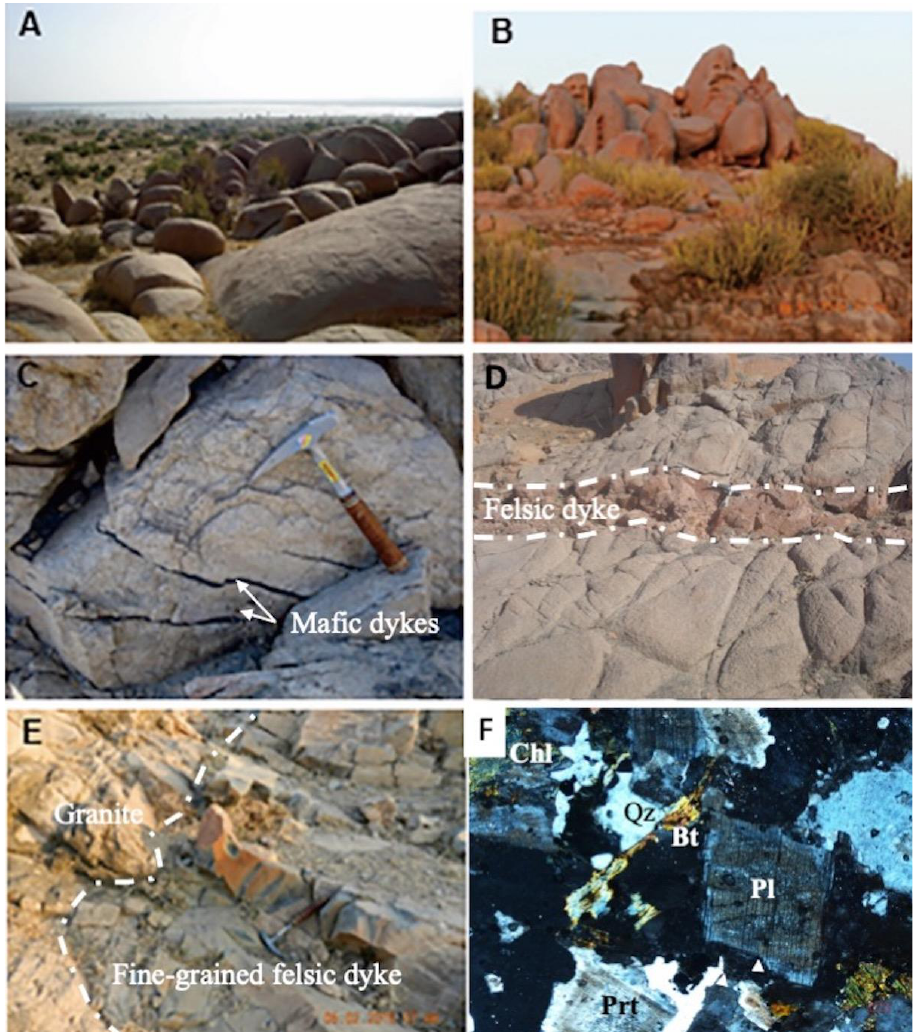
Figure 3. Field and petrographic aspects of the Wadhrai granite. ( A ) Spheroidal weathering in granite. ( B ) Pink color in the weathered granite is further accentuated by the evening sun. ( C ) Fresh granite intruded by thin mafic dykes, hammer for scale. ( D ) Felsic dyke (50 cm wide) in jointed and weathered granite. ( E ) Grey fine-grained felsic dyke (right) in weathered granite (left), hammer for scale. ( F ) Photomicrograph of a typical granite from east central part of the body, composed of perthite (Prt), zoned plagioclase (Pl) showing some alteration, quartz (Qtz), partly chloritized biotite (Bt), chlorite (Chl) and opaque grains. Length of the photograph is 2.5 mm.